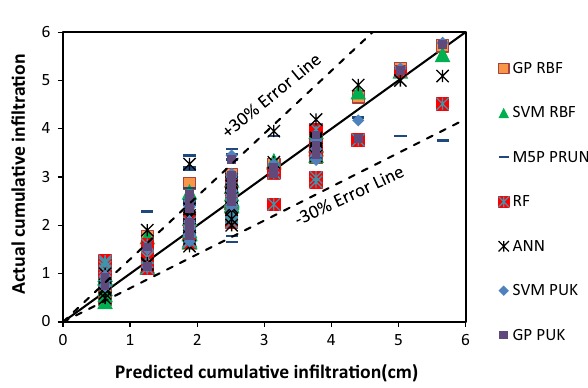
Fig. 10 Actual values versus predicted values using all model for the testing